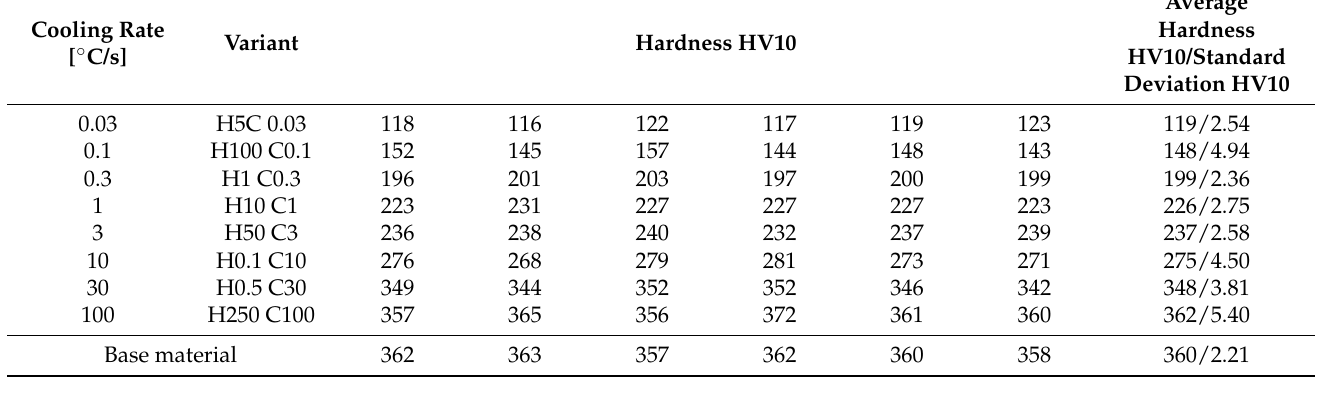
Table 8. The hardness of the final microstructure for different cooling rates.